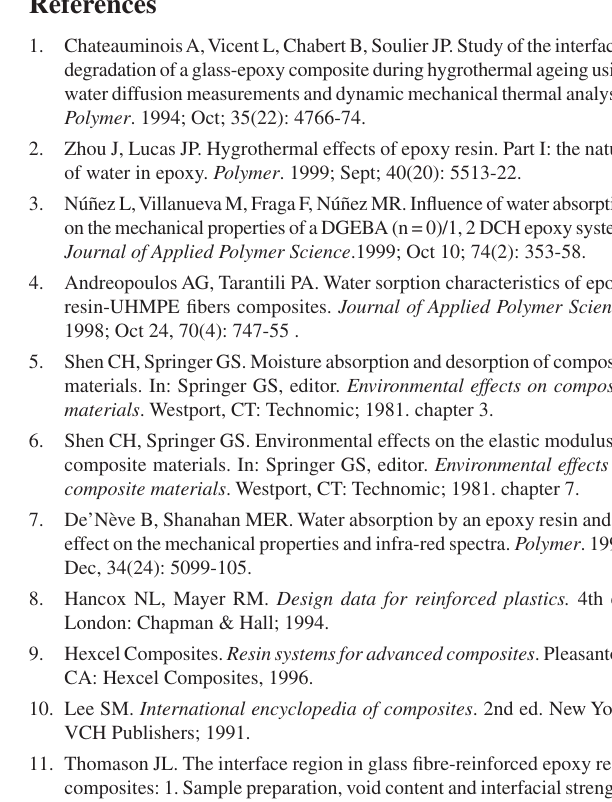
Figure 10. Micrograph of longitudinal fracture of wet carbon/epoxy (2.6% of